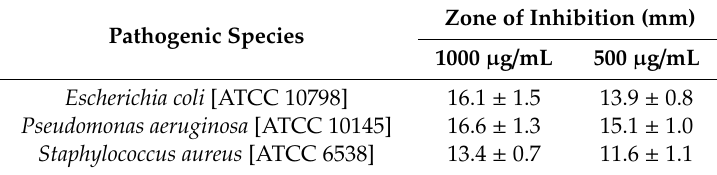
Table 3. Antibacterial efficacy of commercial antibiotics against E.coli , P. aeruginosa and S. aureus .